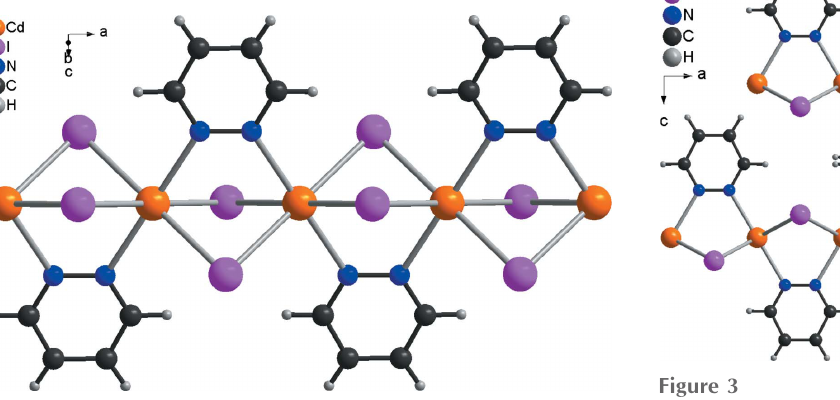
Figure 2 Fragment of a [100] polymeric chain in the crystal structure of 1